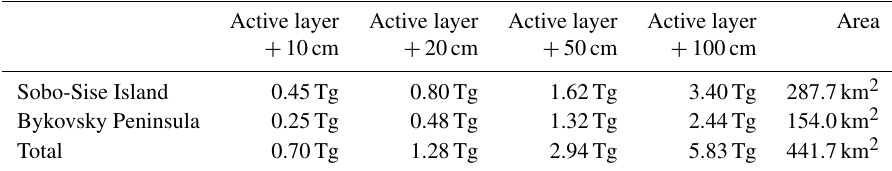
Table 5. Potential C thaw out for different active layer deepening